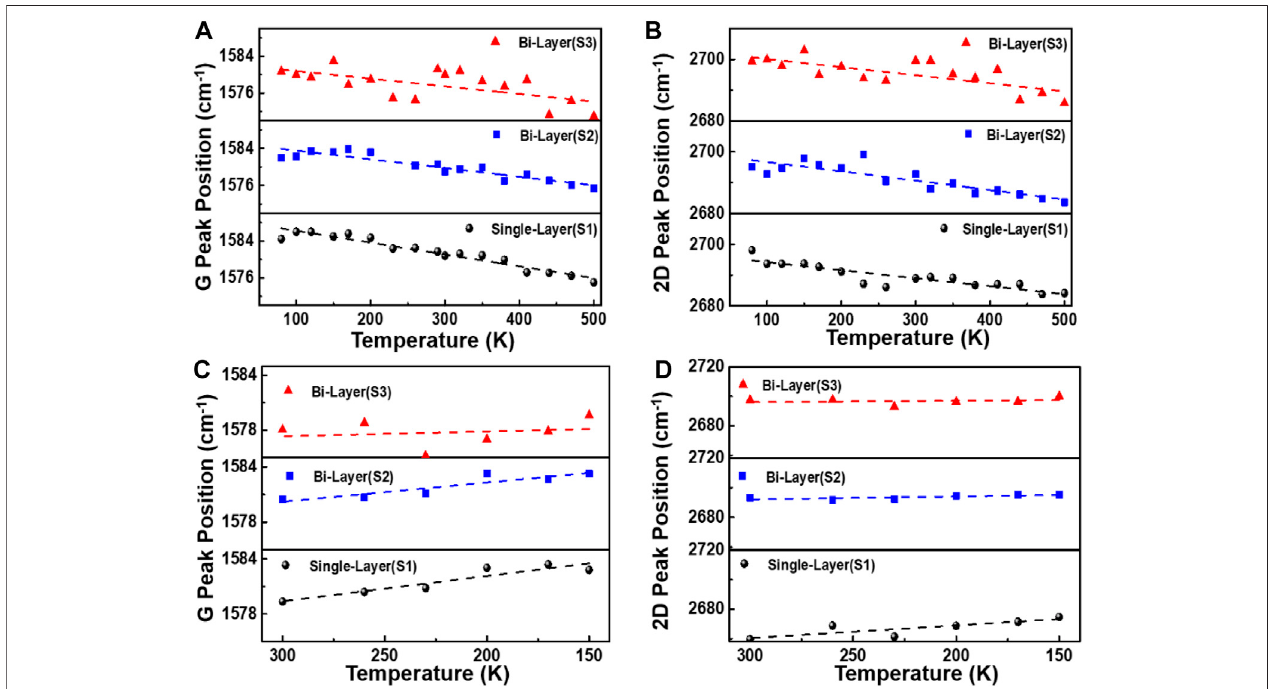
FIGURE 4 | Temperature dependence of Pos (G) and Pos (2D) of samples S1, S2, and S3. (A – D) show the discrete graphs of Pos(G) and Pos(2D) of graphene prepared by different methods, cooled from room temperature to 80 K, and then heated from 80 to 500 K. Each temperature change interval is 30 K.